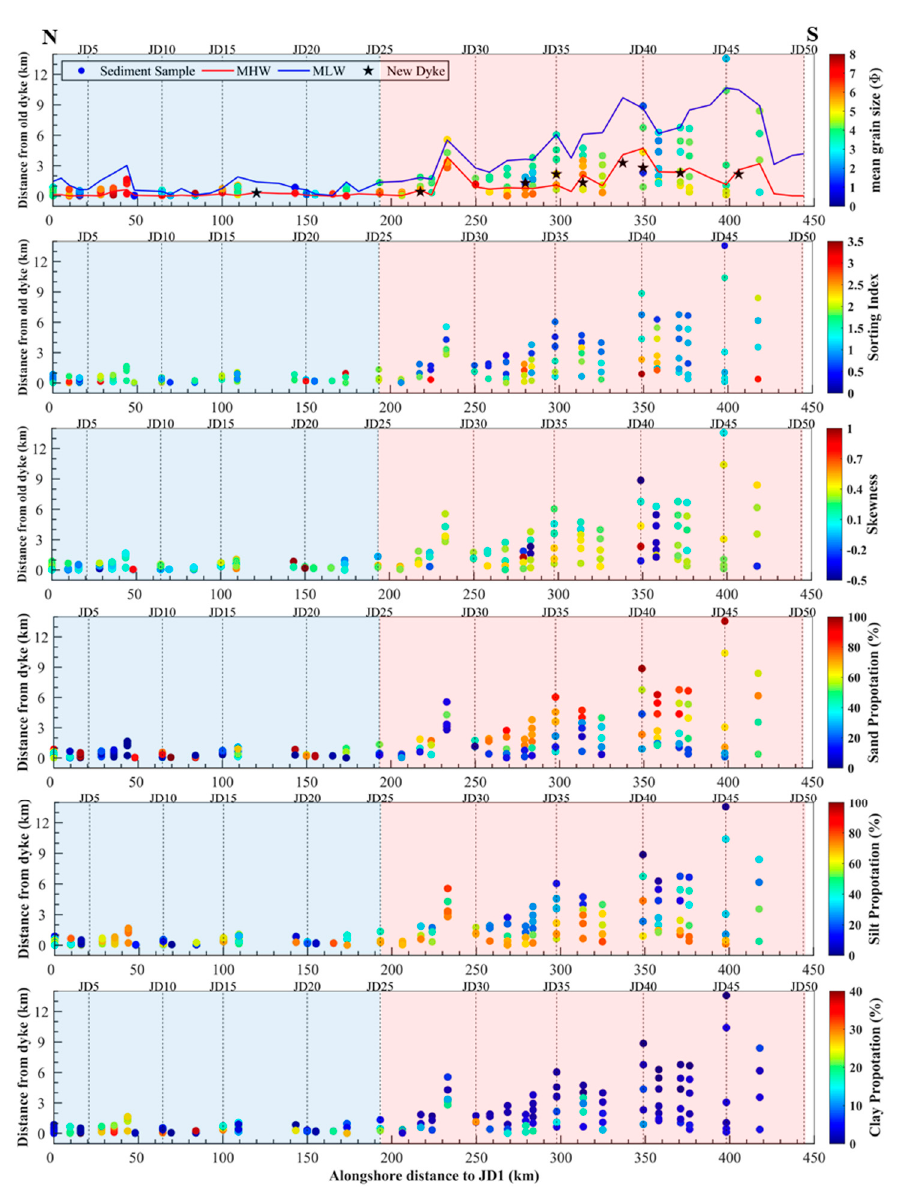
Figure 9. Bed surface sediment characteristic parameters distribution related to distance from old dyke (location of MHW, MLW, and new dykes are marked in the first panel ).